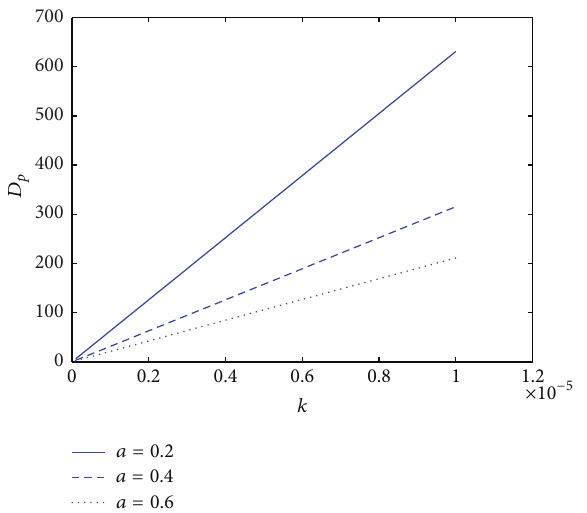
Figure5:Dampingperperiod 𝐷 𝑝 ofslowwavesversuswavenumber k .